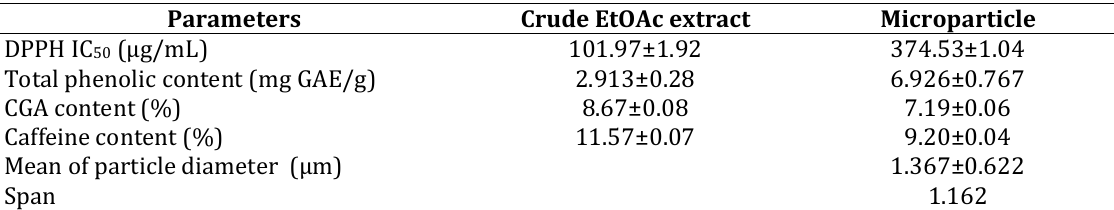
Table II. Parameter values of crude EtOAc extract of GCB and the microparticles Parameters